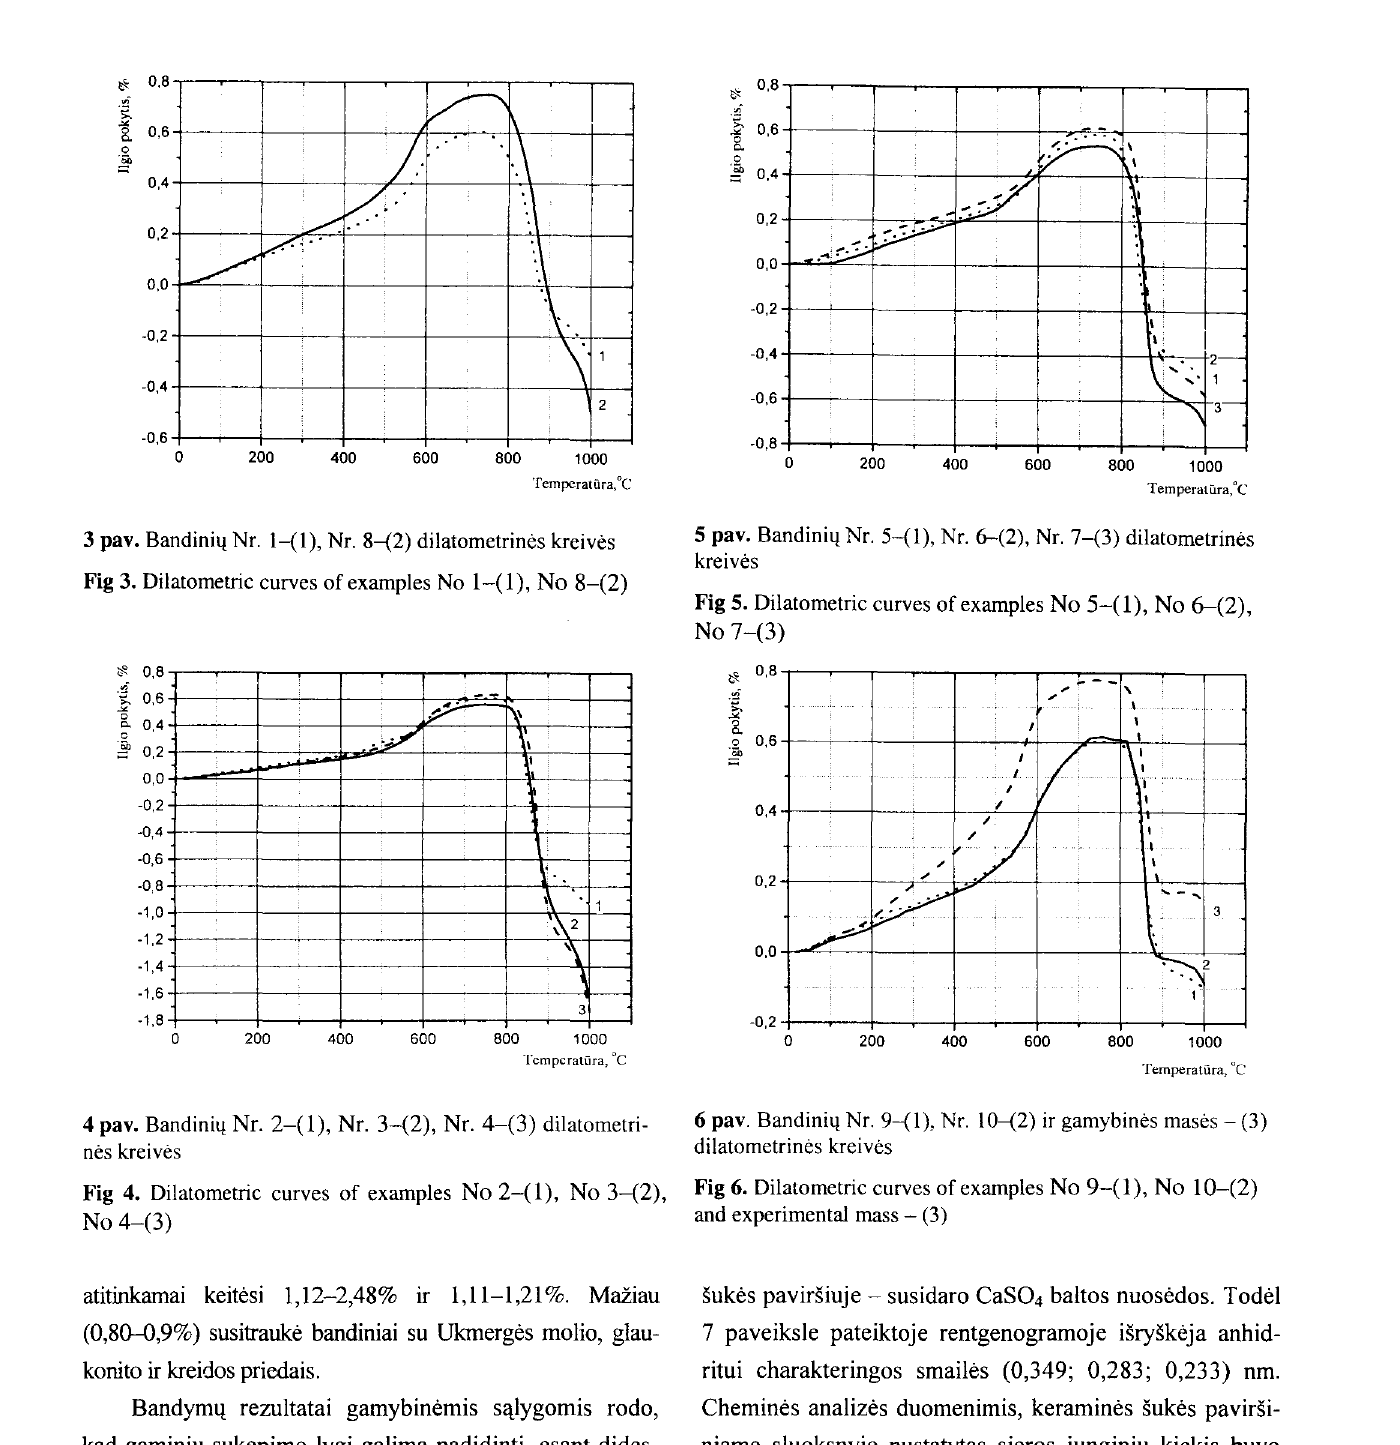
Fig 6. Dilatometric curves of examples No 9-( 1 ), No 10-(2) and experimental mass- (3) sukes pavirsiuje- susidaro CaS0 baltos nuosedos. Todel 4 7 paveiksle pateiktoje rentgenogramoje isryskeja anhid ritui charakteringos smailes (0,349; 0,283; 0,233) nm. Chemines analizes duomenimis, keramines sukes pavirsi niame sluoksnyje nustatytas sieros junginiq kiekis buvo > 2,0% (skaiCiuojant pagal S0 3), o viduriniuose sluoks niuose svyravo nuo 0,36 iki